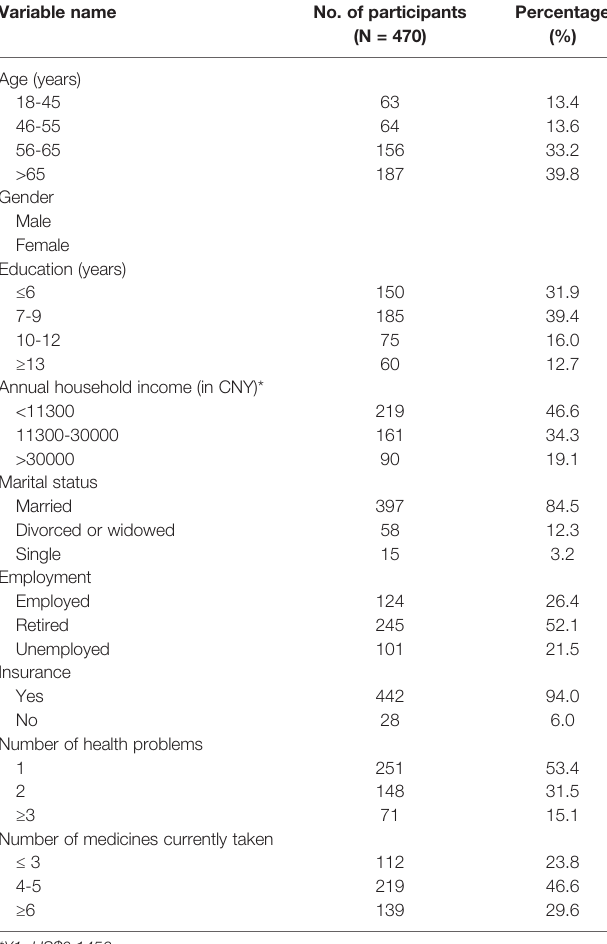
TABLE 1 | Characteristics of the inpatients with coronary heart disease, Changsha, Hunan, China (N=470). Variable